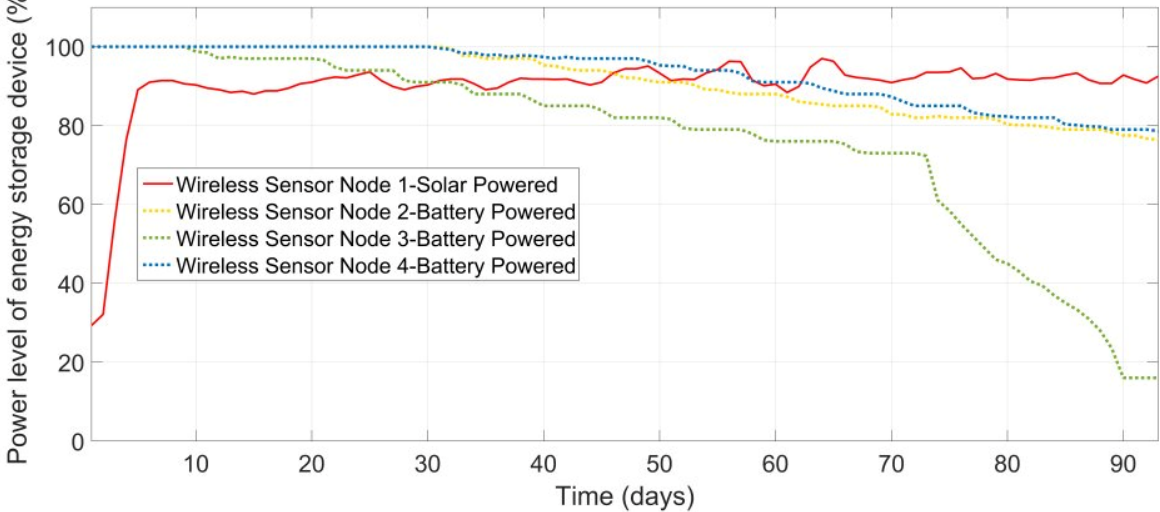
Figure 6. Remaining power of the energy storage devices of the 4 sensor nodes.